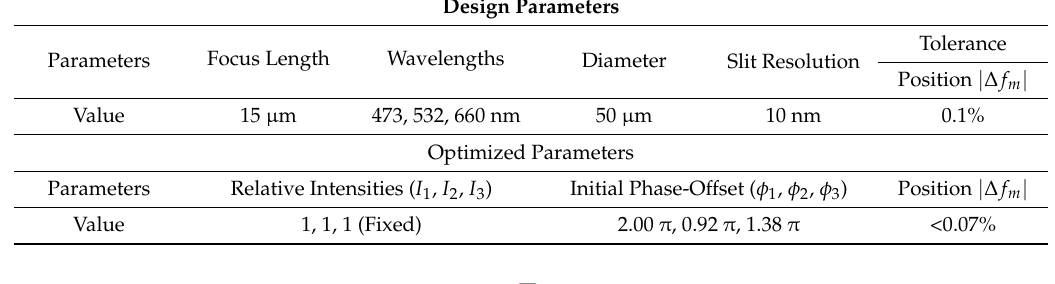
Table 2. Simulation parameters for a multi-chromatic, mono-focal MFZP.